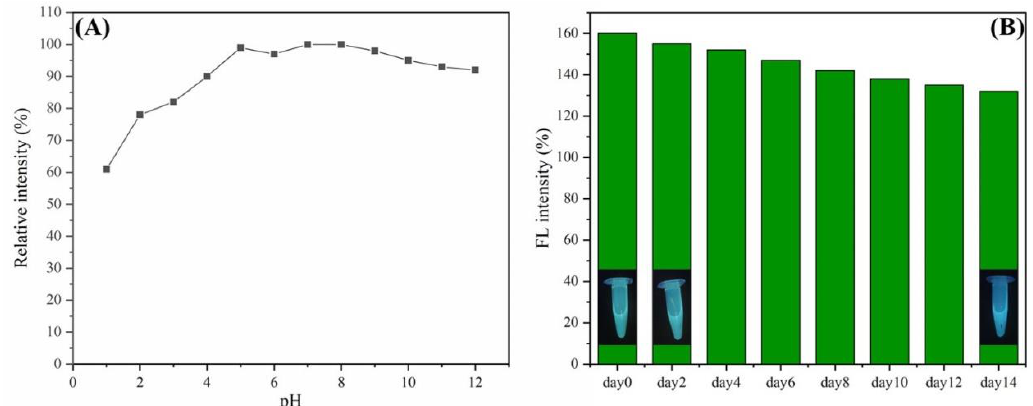
Figure 3. ( A ) Effect of pH on the fluorescence intensity of L-CDs; ( B ) the fluorescence intensities of the synthesized CDs at different storage times.